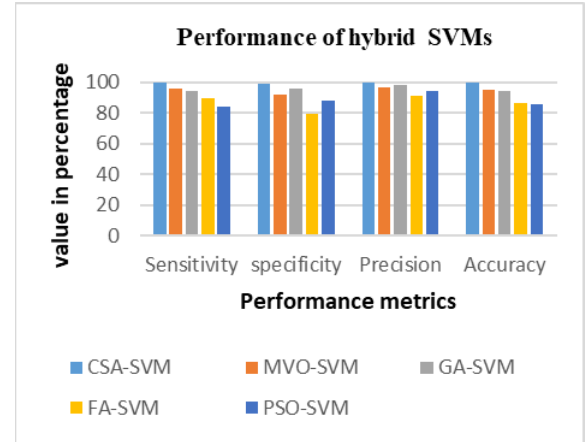
Figure 2. Performance chart of hybrid SVMs Table 5. Performance comparison of works